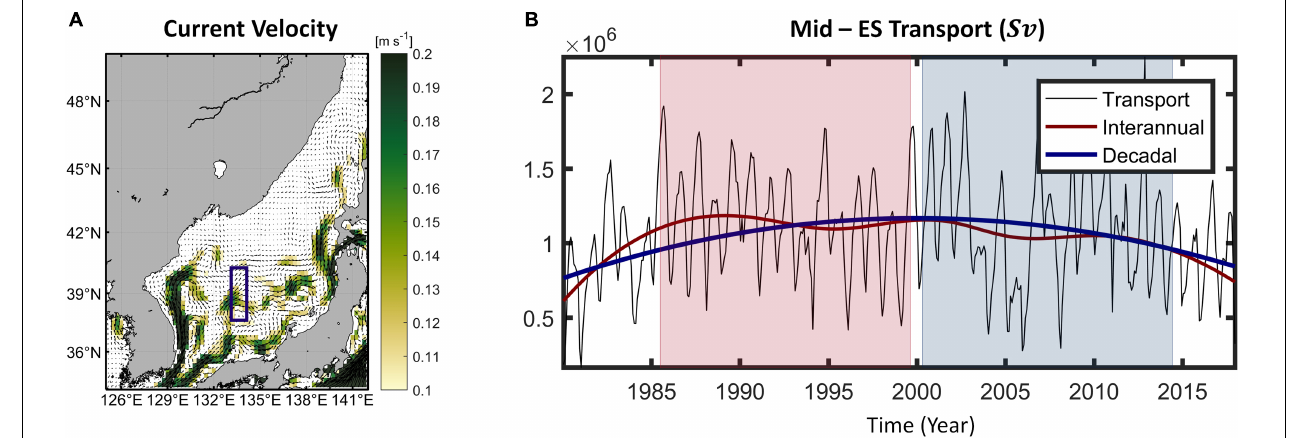
FIGURE 5 | (A) Average spatial pattern of current in the ES in 2017. Shading indicates the current velocity, and only the region with a value higher than 0.1 m s − 1 is denoted. The blue rectangle is the region that we set as the Mid-ES (133 ◦ E , 37–40 ◦ N ). (B) Timeseries of the current transport in the Mid-ES. Black, red and blue lines indicate monthly transport, interannual, decadal variation of transport in the Mid-ES, respectively.